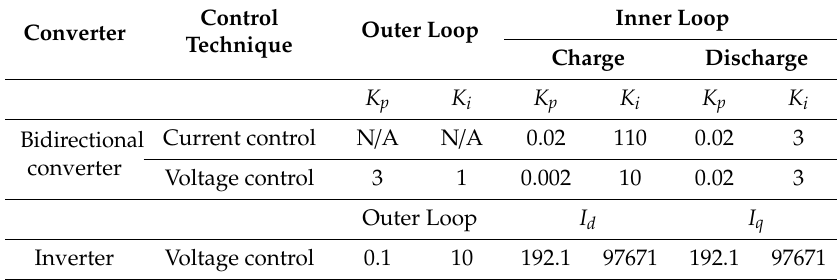
Figure 7. Control scheme and logics implemented for the DC MG during grid-tie and islanded modes. Table 3. Proportional and Integral Gains of Various Control Technique Used in the Studied DC MG.